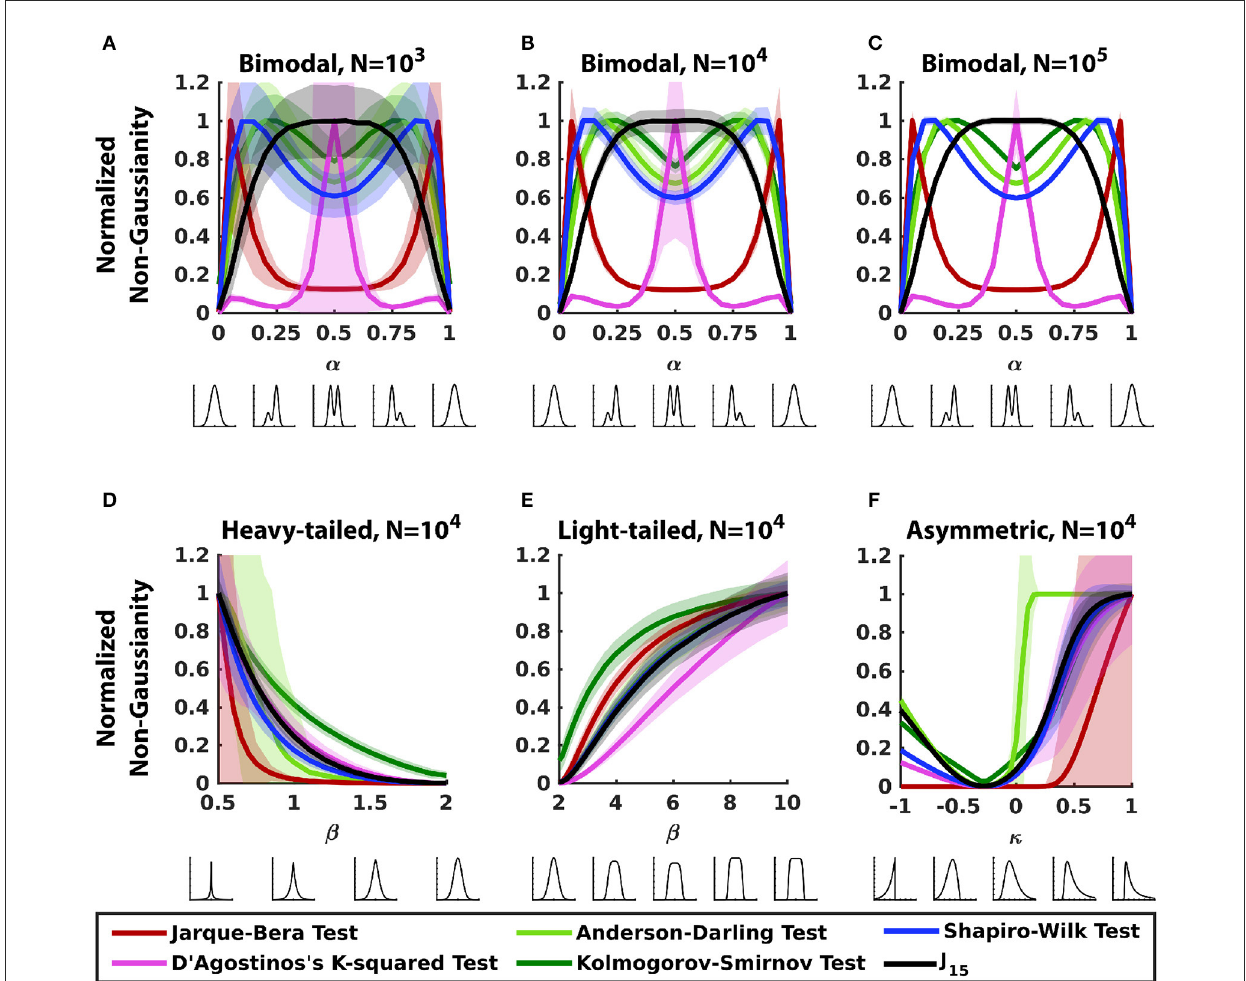
FIGURE1 Comparing sensitivity of J 15 and standard normality tests for 1D datasets. Each panel analyzes a parametric family of distributions, shown below each abscissa (see Section 2.3 for details). (A–C) Bimodal distributions (Section 2.3.1) with a range of sample sizes. (D) Heavy-tailed distributions (Section 2.3.2). (E) Light-tailed distributions (Section 2.3.2). (F) Asymmetric distributions (Section 2.3.3). Within each panel, measures were normalized so that the maximum value of the mean is 1. Error bars correspond to 2 SD ±